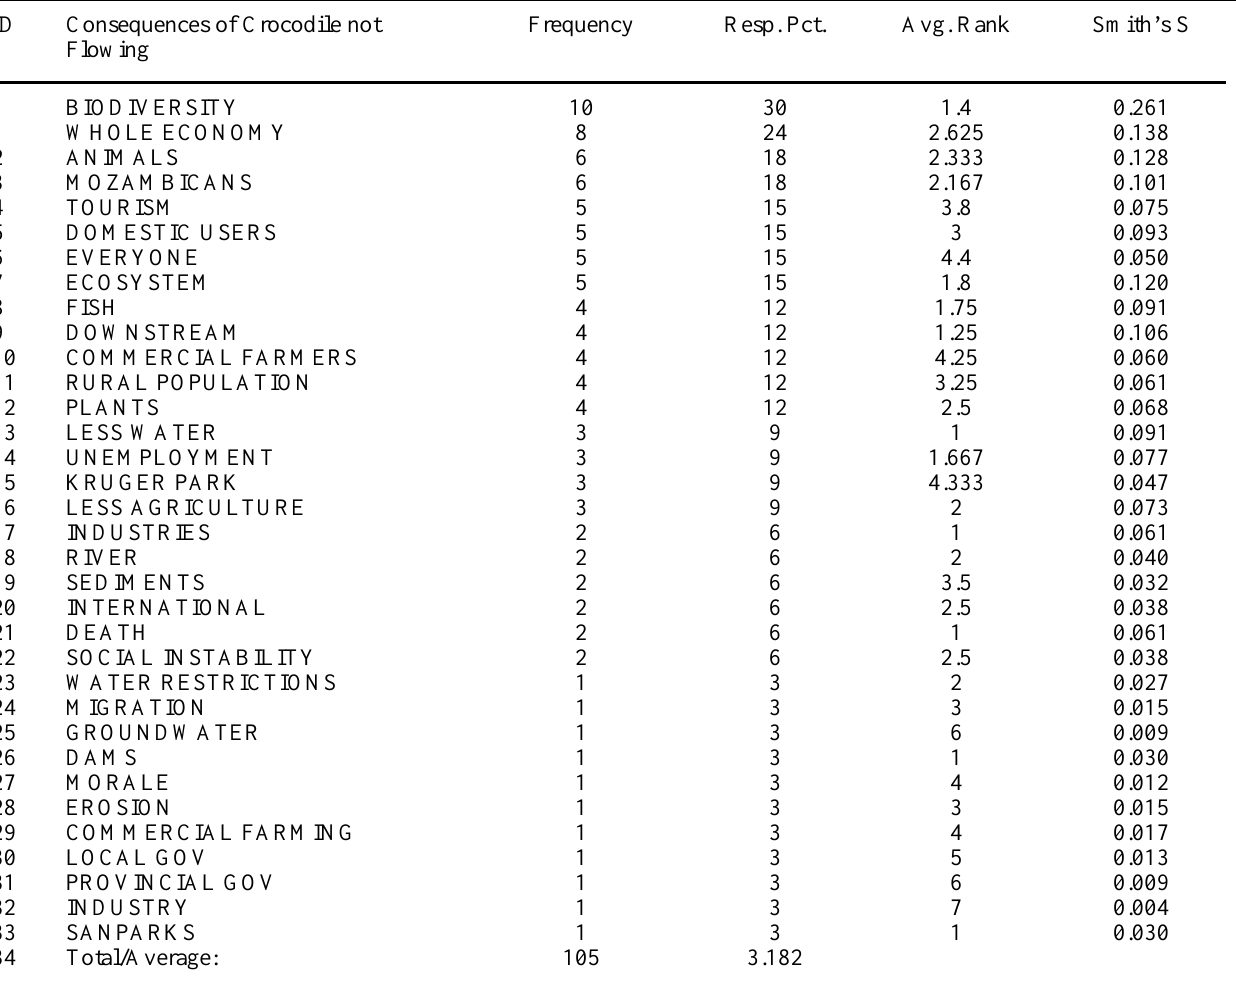
Table 6 . Results of analysis of freelists of “consequences of the Crocodile River not flowing?”, showing frequency with which interviewees identified consequences, the percentage of interviewees who identified that consequence, the average ranking of that consequence, and the salience (Smith's S) of the consequence. ID Consequences of Crocodile not Frequency Resp. Flowing